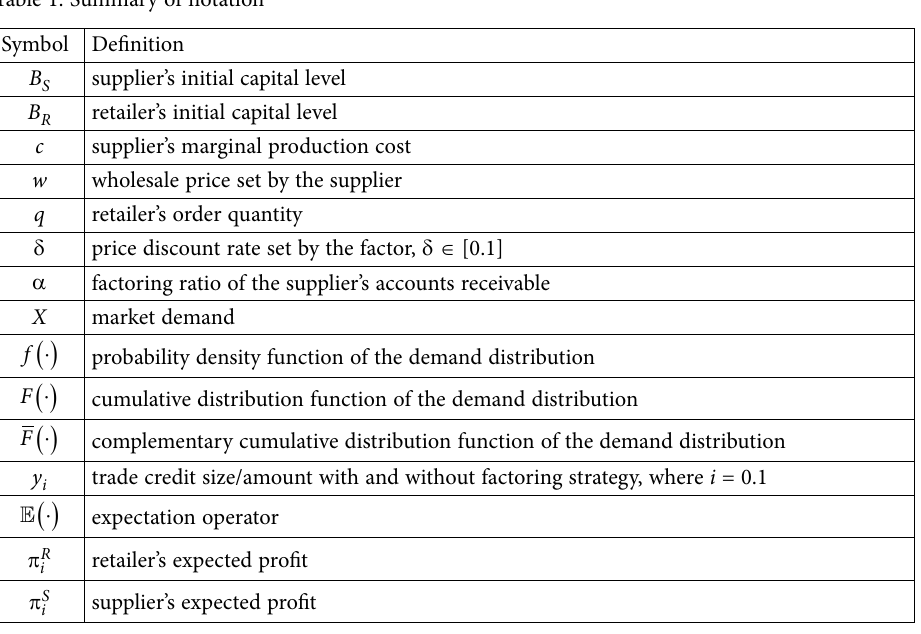
Table 1. Summary of